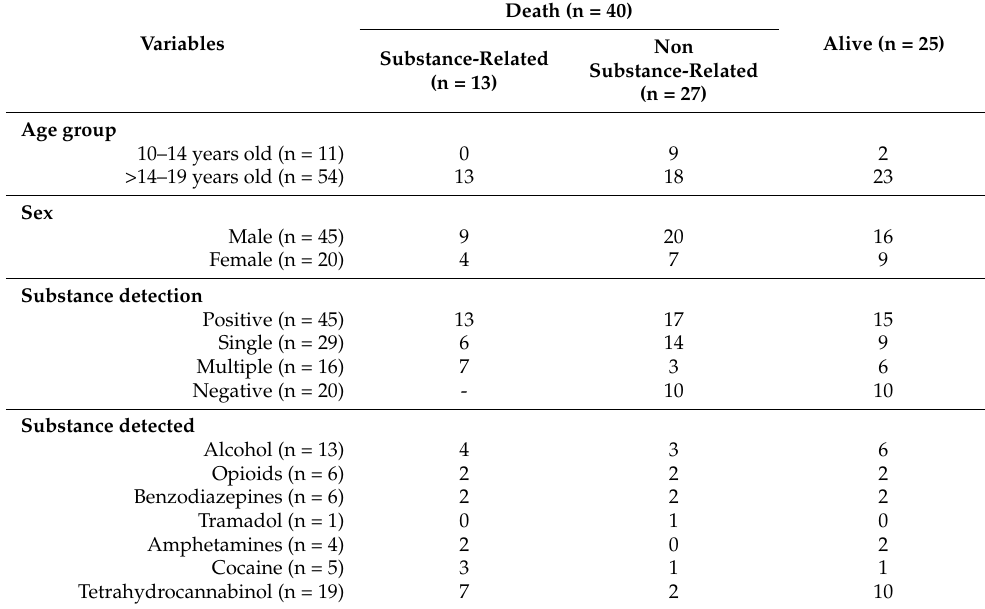
Table 1. Characteristics of adolescents referred to the medico-legal section of the Toxicology Unit, University Hospital of Lille, France